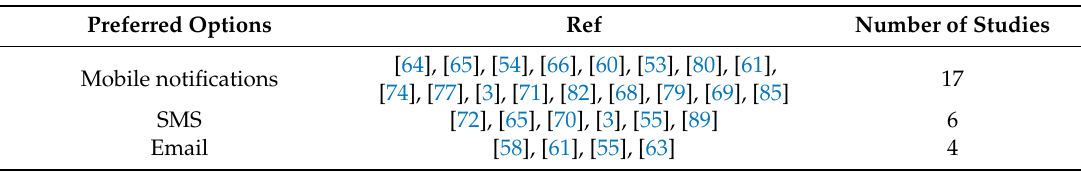
Table 7. Preferred notification